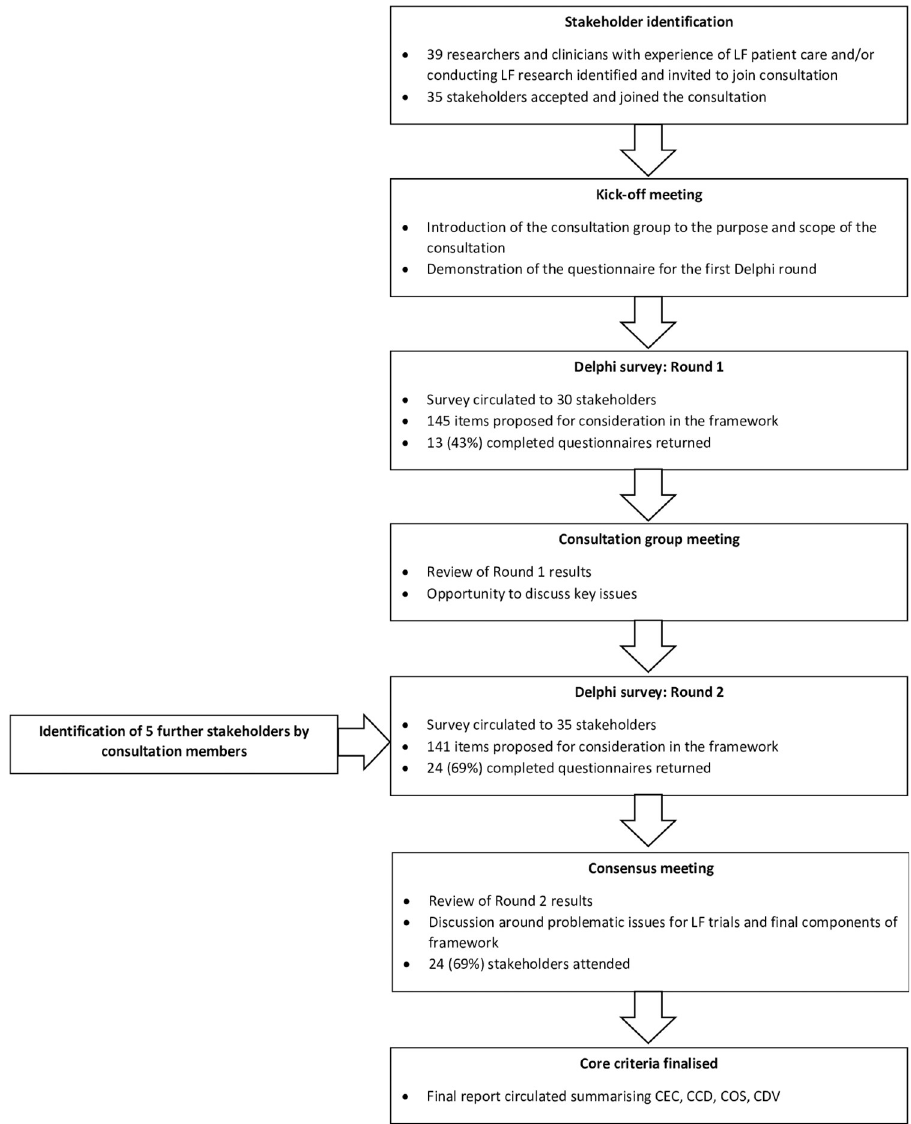
Fig 1. Flowchart illustrating the consultation